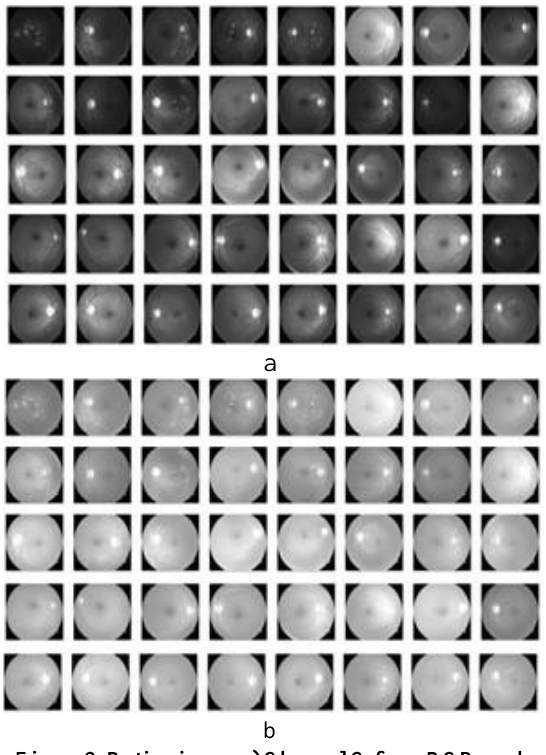
Figure 2. Retina image a) Channel G from RGB, and b) Channel L from Luv color